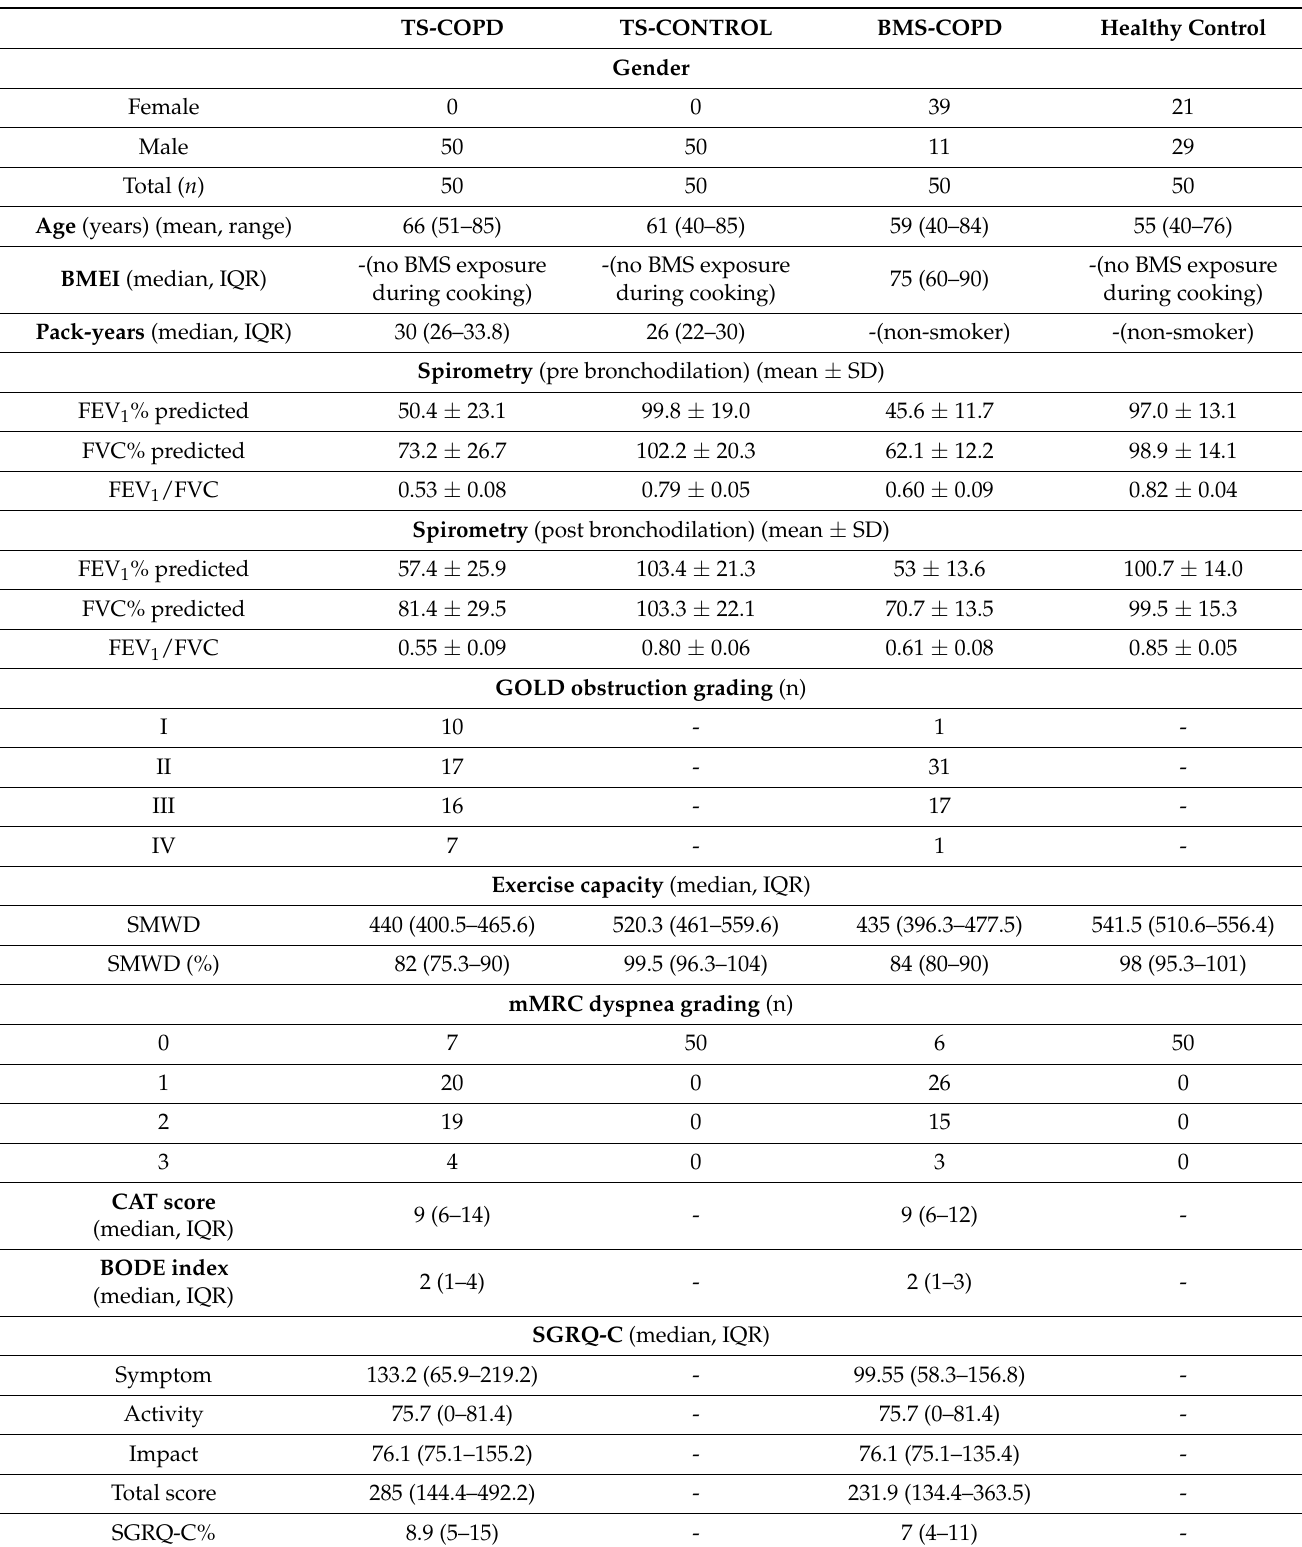
Table 1. Demography and clinical characteristics of the study